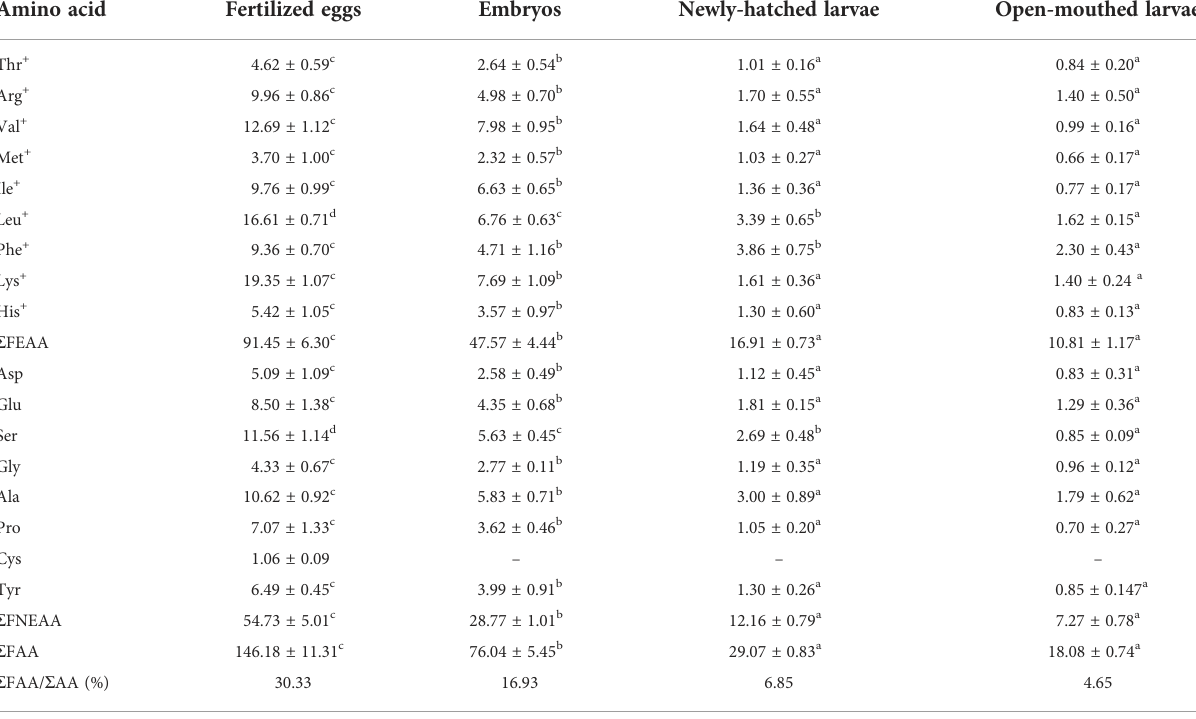
TABLE 2 Changes in the total content of free amino acid for cobia in early development stages (mg/g dry weight). Amino acid Fertilized eggs Embryos Newly-hatched larvae